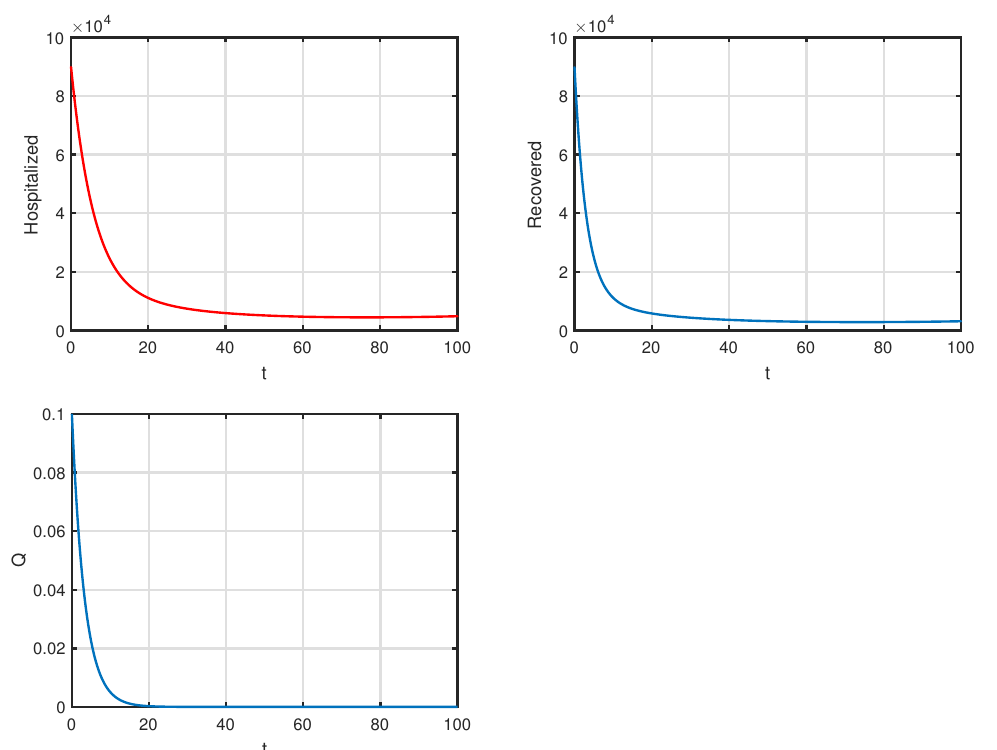
Figure 4. Time series of H , R , Q for 100 days from 1 January 2022 to 10 June 2022 when controls (both government measures and public behaviour) are